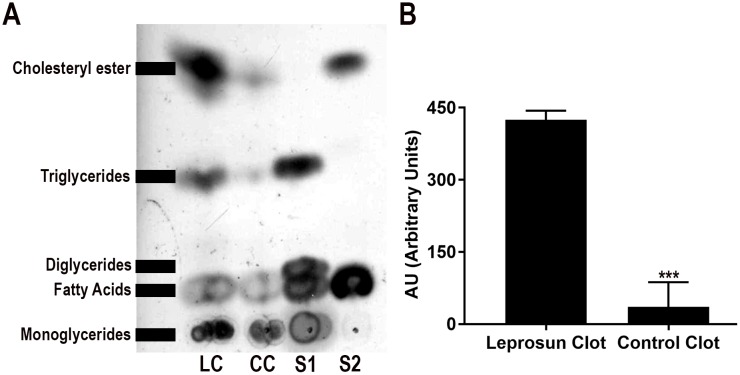
Neutral lipid content in control and leprosum clots.A) Representative image of a high-performance thin layer chromatography of a leprosum clot (LC) and control clot (CC) showing similarities in their compositions but differences in their amounts of neutral lipids. The lipid standards, S1 and S2, were composed of monoglycerides, diglycerides, and triglycerides (S1) and fatty acids and cholesteryl ester (S2). B) Densitometric analysis of (A) by ImageJ software shows the relative abundance of total neutral lipids in each sample in arbitrary units. Image is representative of four independent experiments. *** indicates p<0.0001 by t test using Mann-Whitney.